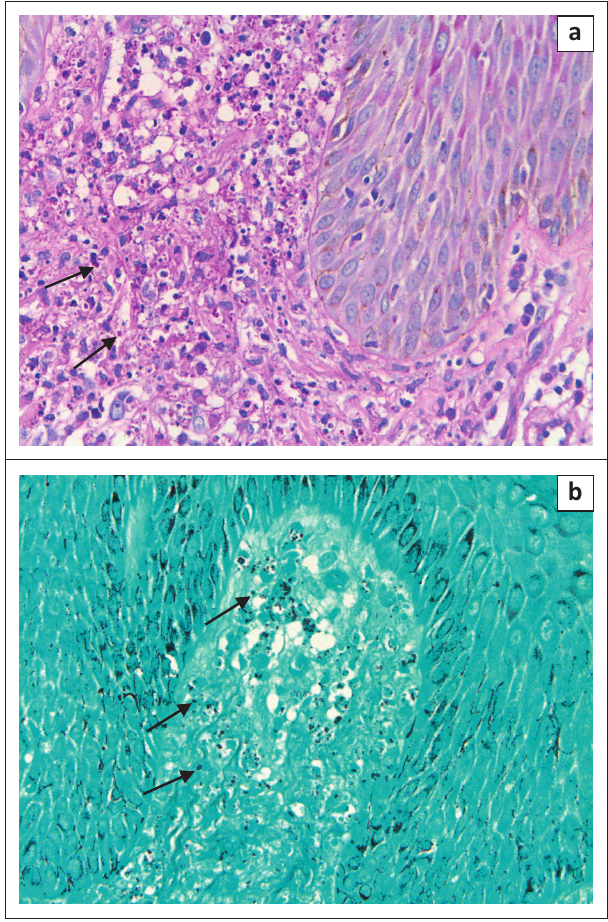
Note: The arrows identify the organism. FIGURE 2: Skin histology biopsy demonstrating fungal elements